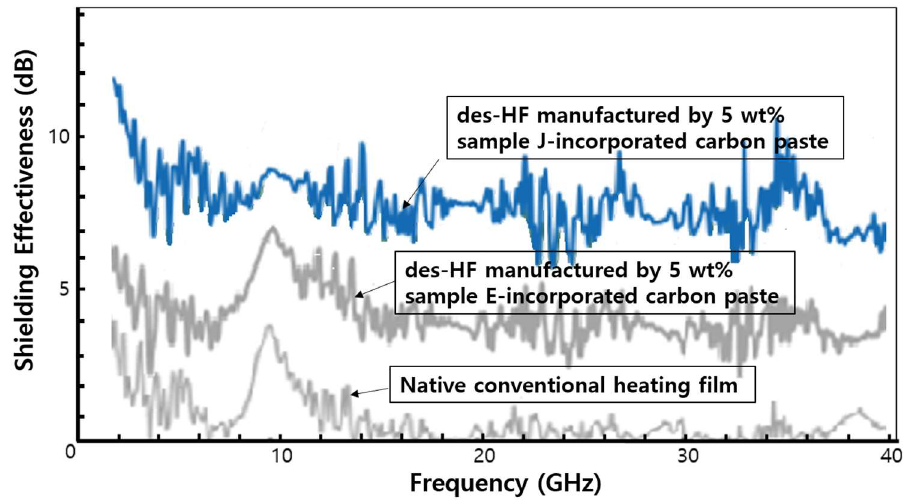
Figure 7. The total SE values for the conventional heating film using native commercial carbon paste, the des-HF manufactured by 5 wt% sample-E incorporated carbon paste, and the des-HF manufac- tured by 5 wt% sample-J incorporated carbon